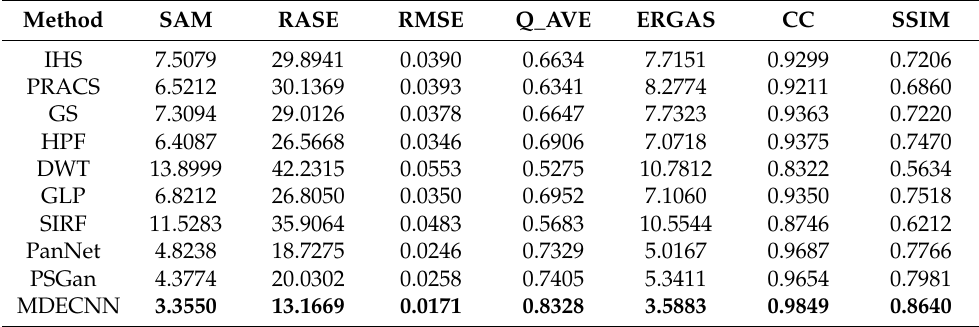
Figure 9. Results of the QuickBird dataset with four bands and 256 × 256 size. ( a ) Reference image; ( b ) PAN image; ( c ) IHS; ( d ) PRACS; ( e ) GS; ( f ) HPF; ( g ) DWT; ( h ) GLP; ( i ) SIRF; ( j ) PanNet; ( k ) PSGan; ( l ) MDECNN. Table 4. Quantitative assessment of the QuickBird dataset shown in Figure 9. The best performance is shown in bold.